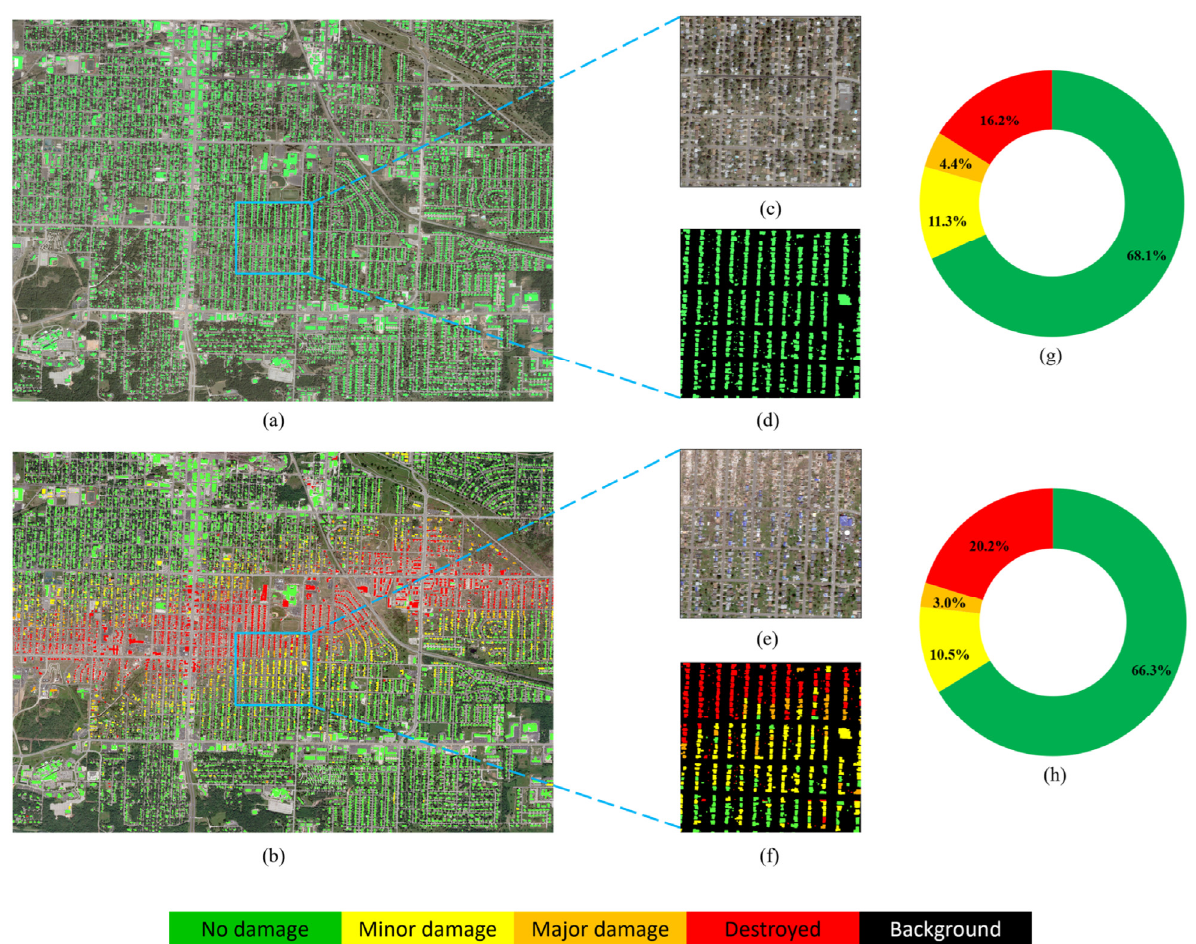
Figure 9. Damage assessment for an example region of Joplin Tornado. ( a ) Building localization results, ( b ) building damage classification results, ( c ) sub-region of the pre-disaster image, ( d ) sub- region of building localization results, ( e ) sub-region of the post-disaster image, ( f ) sub-region of building damage classification results, ( g ) statistics of ground truth data, and ( h ) statistics of our assessment results.